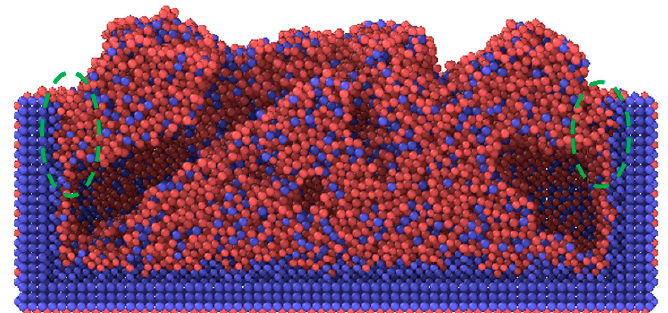
Figure 6. Phase of the deposited material showing austenite (blue) and martensite (red), respectively. The green dotted circles reflect the wall-adhesion region.